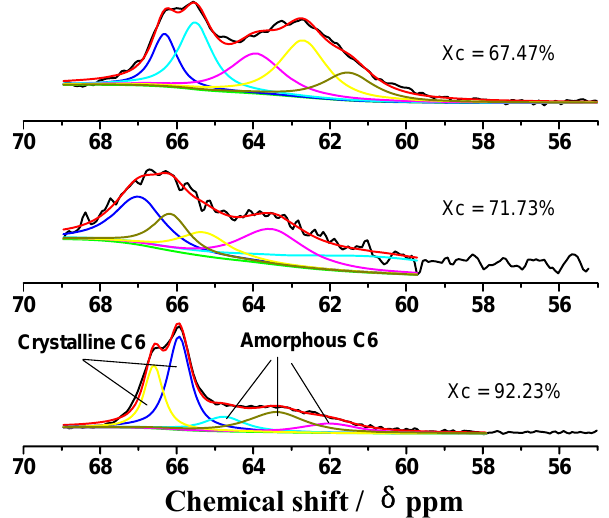
Figure 5. Results of fitting the C region of CP/MAS 13 C-NMR spectra from MCC with 6 different degrees of crystalline structure: The proportions of crystalline cellulose are identified in the first peaks; the proportions of amorphous cellulose are identified in the second peaks.